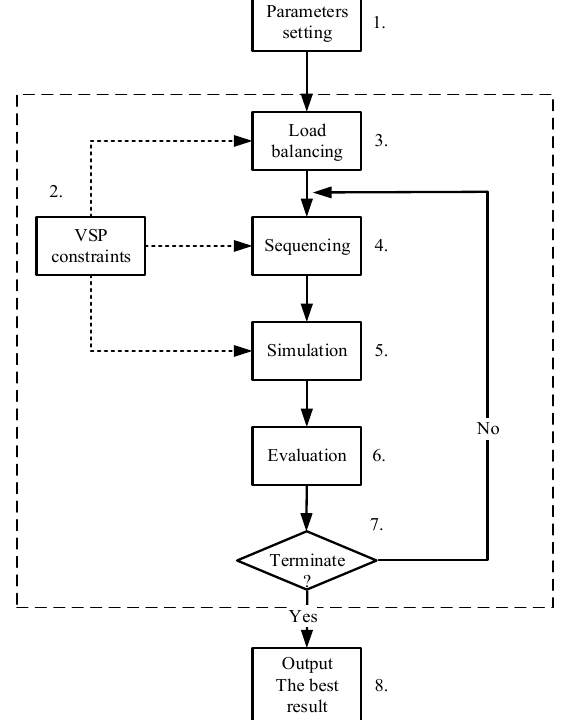
Figure 6. The framework of a simulation-based optimization approach.